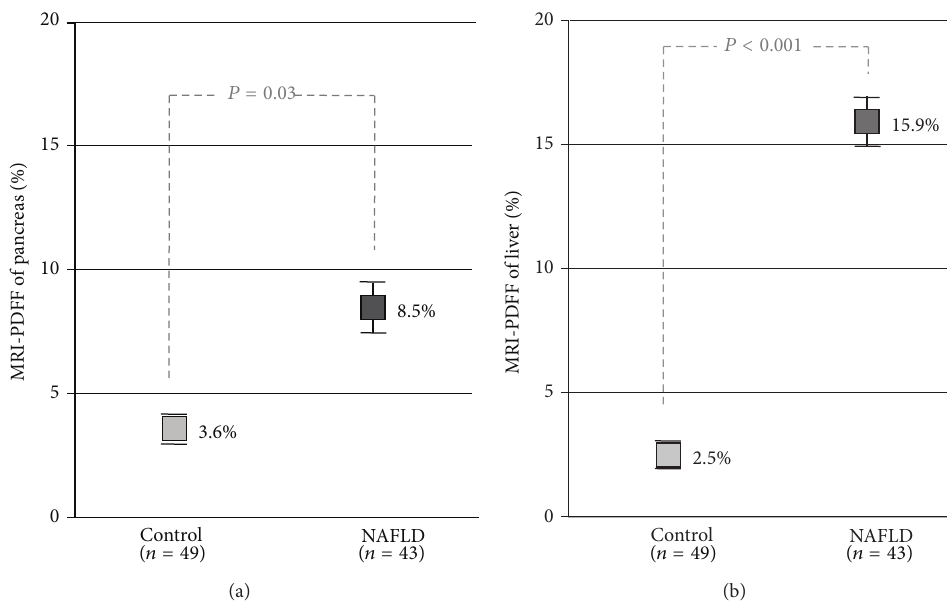
Figure 1: MRI-estimated pancreatic and liver fat content in healthy controls versus NAFLD patients. Mean magnetic resonance imaging (MRI) proton-density-fat-fraction (PDFF) is shown for the pancreas and liver. Standard error bars are shown. 𝑃 -value, determined using multivariable linear regression to correct for differences in age, sex, body mass index (BMI), and diabetes, is shown.